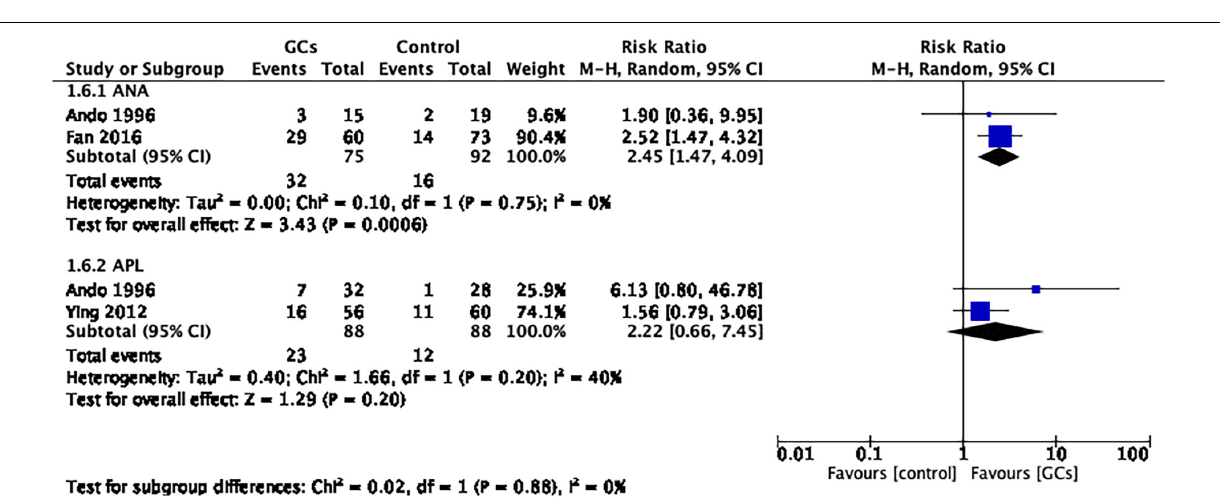
FIGURE 5 | Forest plot for comparison: glucocorticoids versus no glucocorticoids/placebo, outcome: II. II Live birth rate per couple in subgroups by autoantibody. Glucocorticoids improved the live birth rate in women with positive ANA (RR 2.45, 95% CI 1.47–4.09, p = 0.0006, two cohort studies, 167 women, I 2 = 0%). However, in women with positive APL, the result remained controversial (RR 2.22, 95% CI 0.66–7.45, p = 0.20, two cohort studies, 176 women, I 2 =